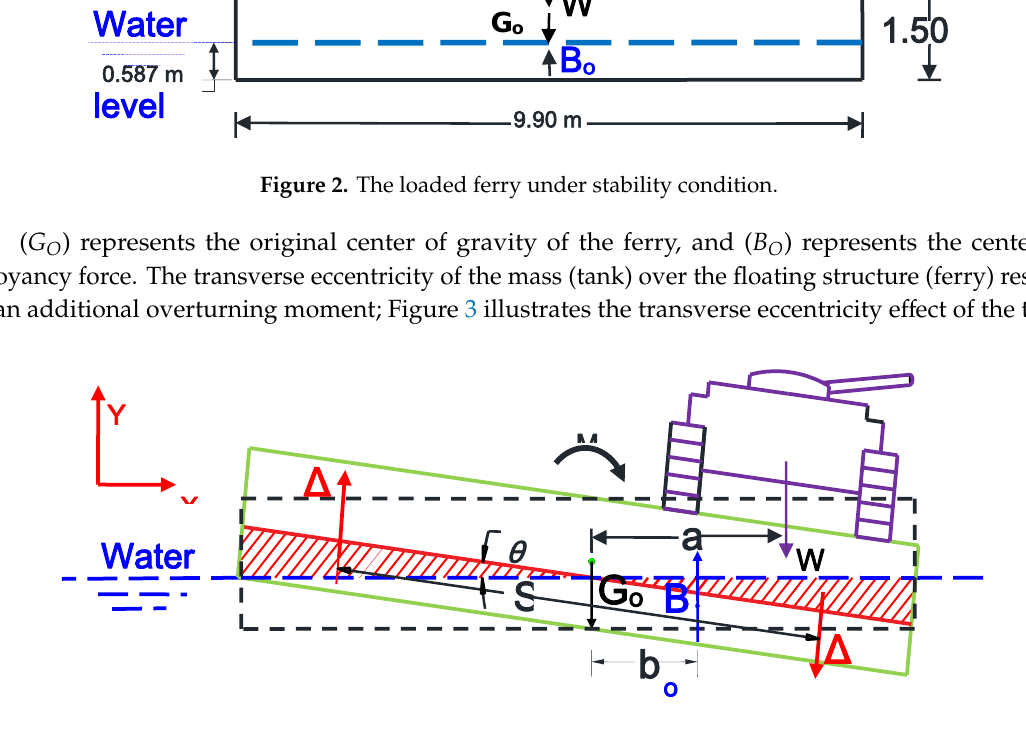
Figure 3. The loaded ferry under stability condition (with transverse eccentricity).